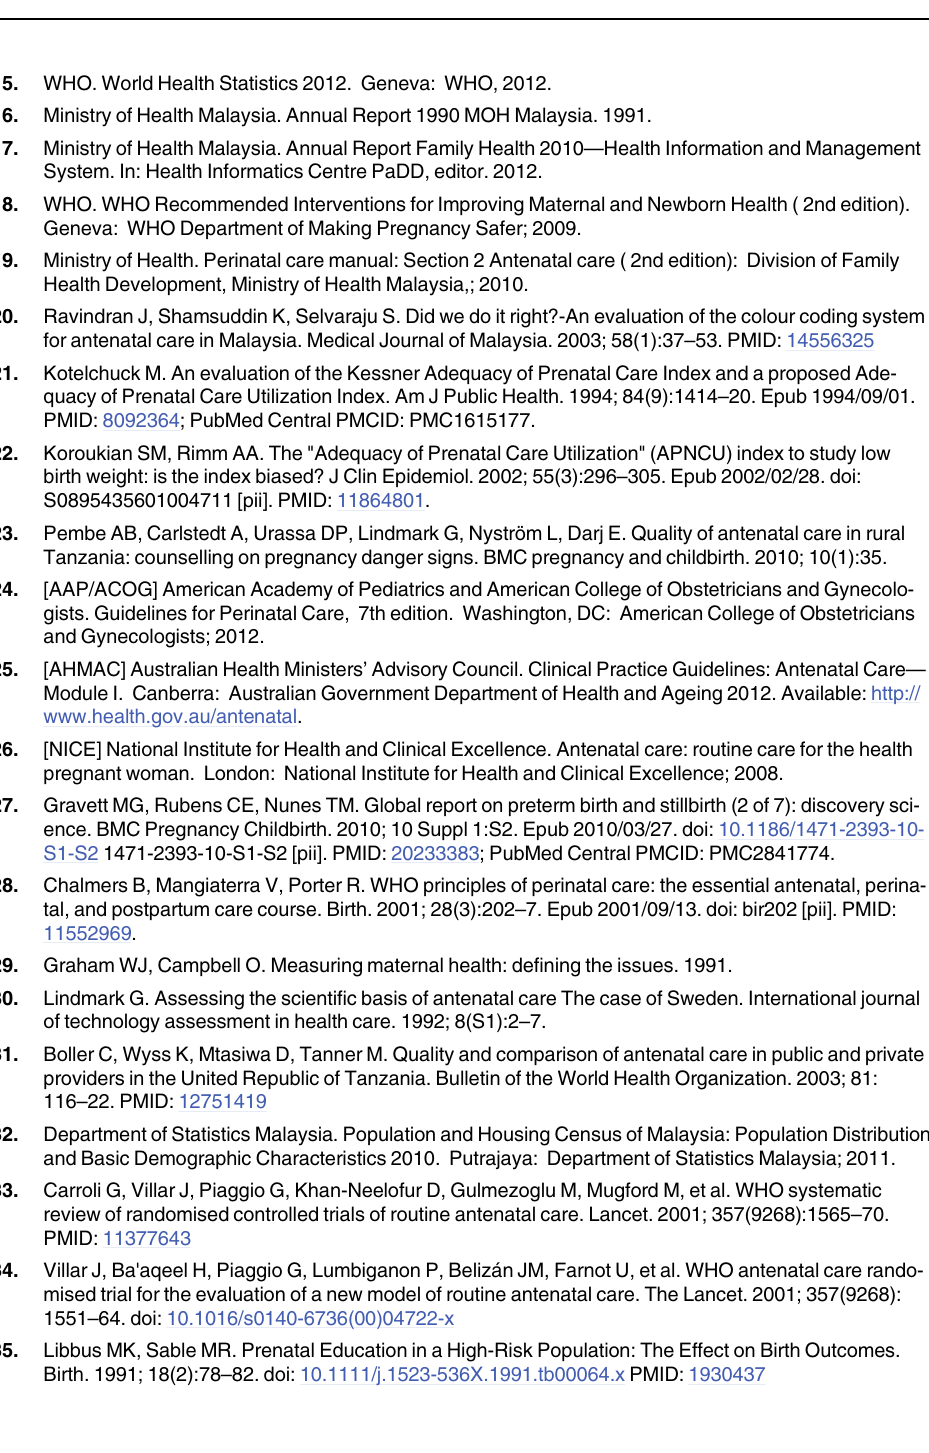
PLOS ONE | DOI:10.1371/journal.pone.0135301 August 13,